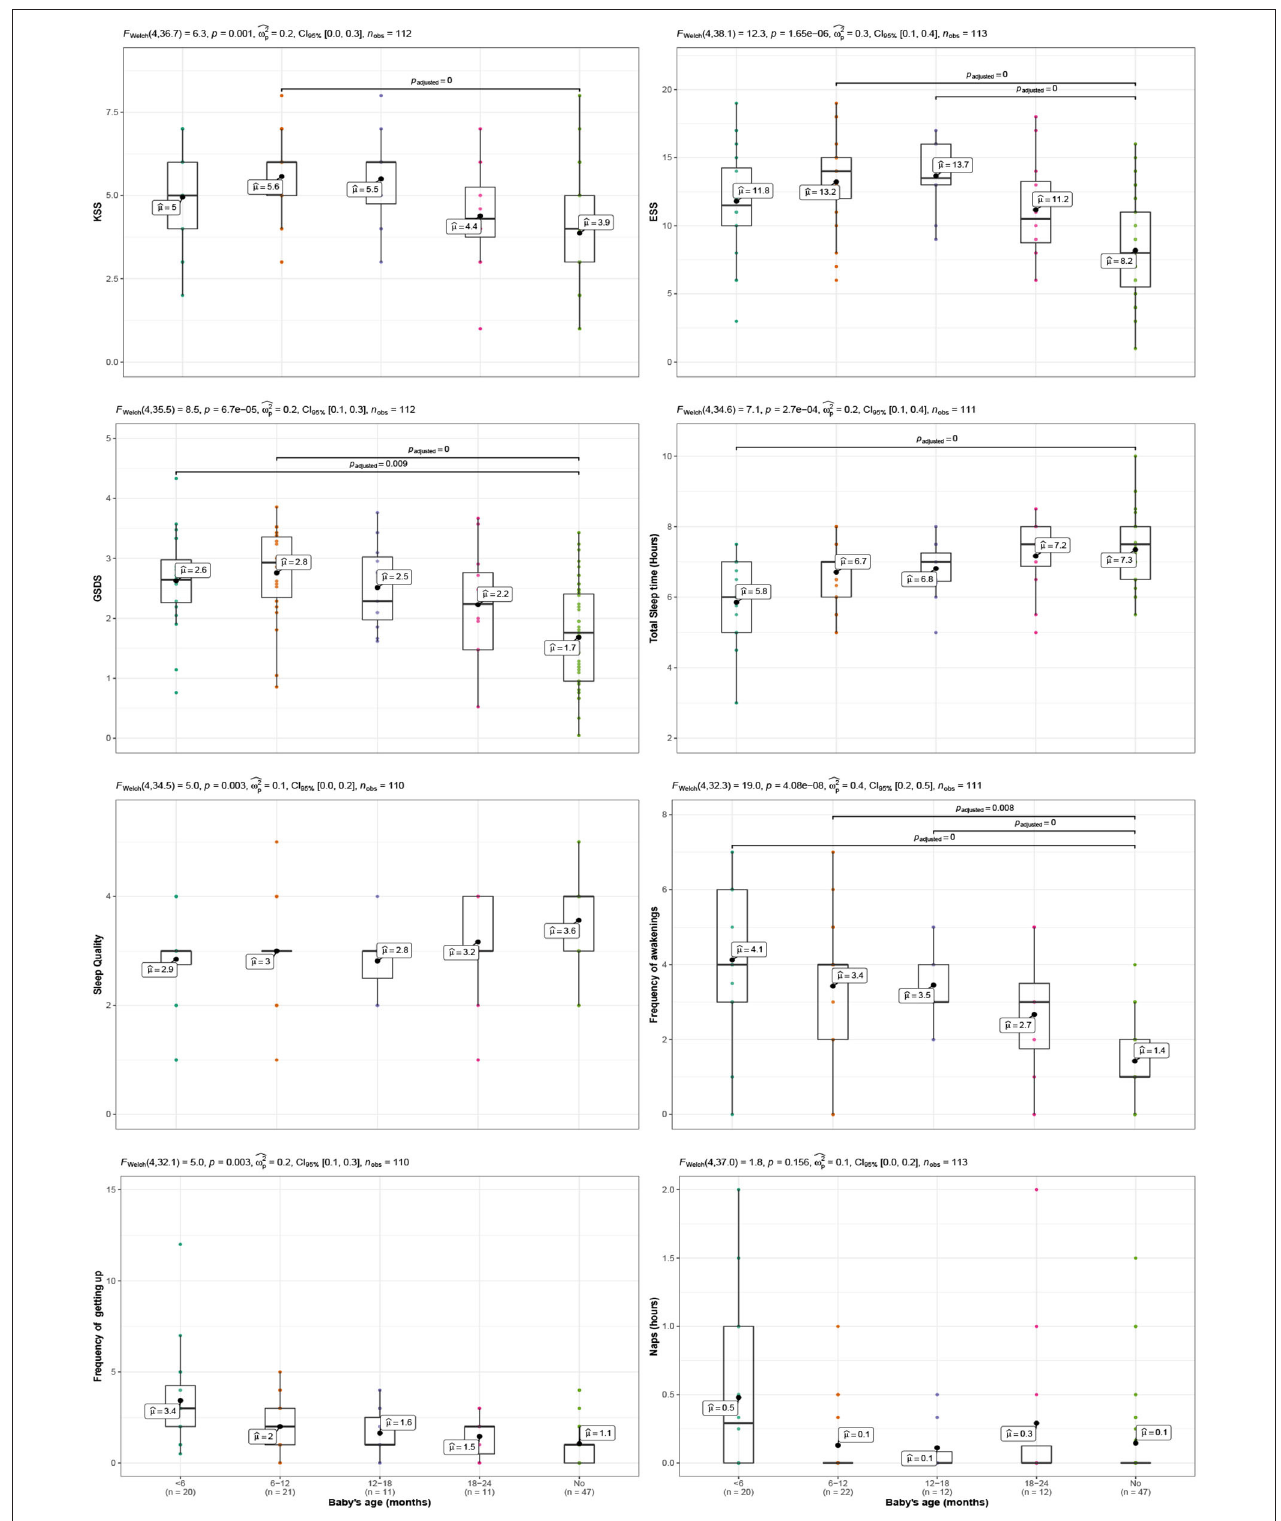
FIGURE 2 | Comparison of sleepiness variables in two cases: that of mothers of newborn babies, whose ages are split into four groups (groups <6 months old, 6–12 months old, 12–18 months old, 18–24 months old) and that of women who have not been mothers recently (No group). Each variable is shown in a panel and each of the panels includes information on the result of an ANOVA test, eta squared, its confidence interval, the sample size, and inter-group comparisons -only shown if significant- assuming unequal variances (Games-Howell) and adjusting for the number of comparisons using the Holm’s method.